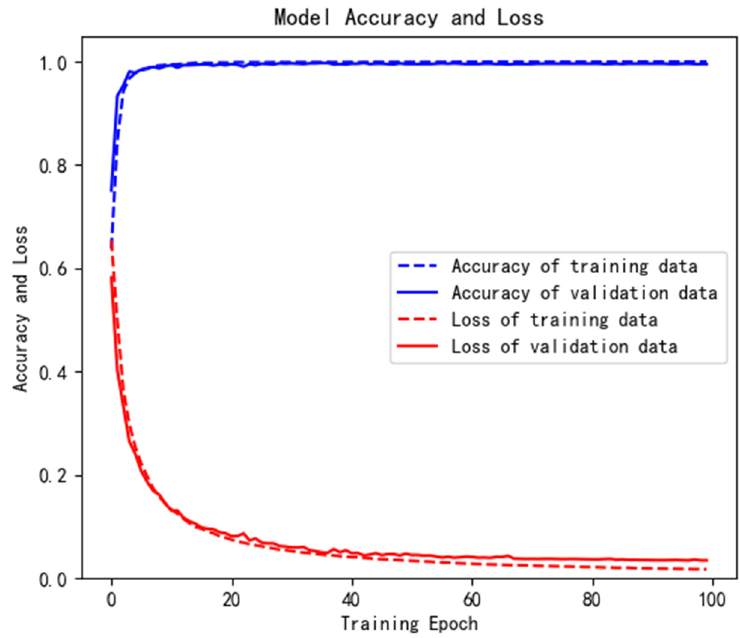
Figure 7. Iterative curve of training process.